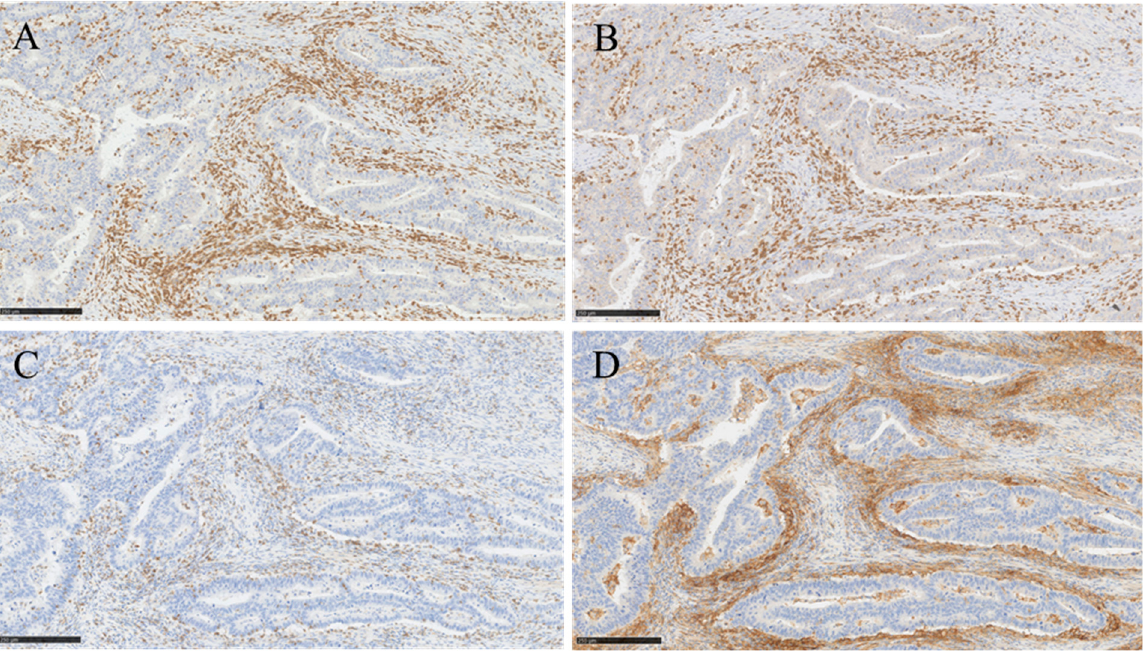
Figure 1. Immunohistohistochemical staining of CD3, CD8, PD-1 and PD-L1 in primary colorectal tumour. Figures ( A , B ) show representative immunostaining of high infiltrates of CD3 ( A ) and CD8 lymphocytes ( B ), respectively. Figures ( C , D ) show representative immunostaining of high PD-1 expression ( C ) and strong expression of PD-L1 in immune cells ( D ) surrounding the tumour area (10× magnification, scale bar 250 µm).